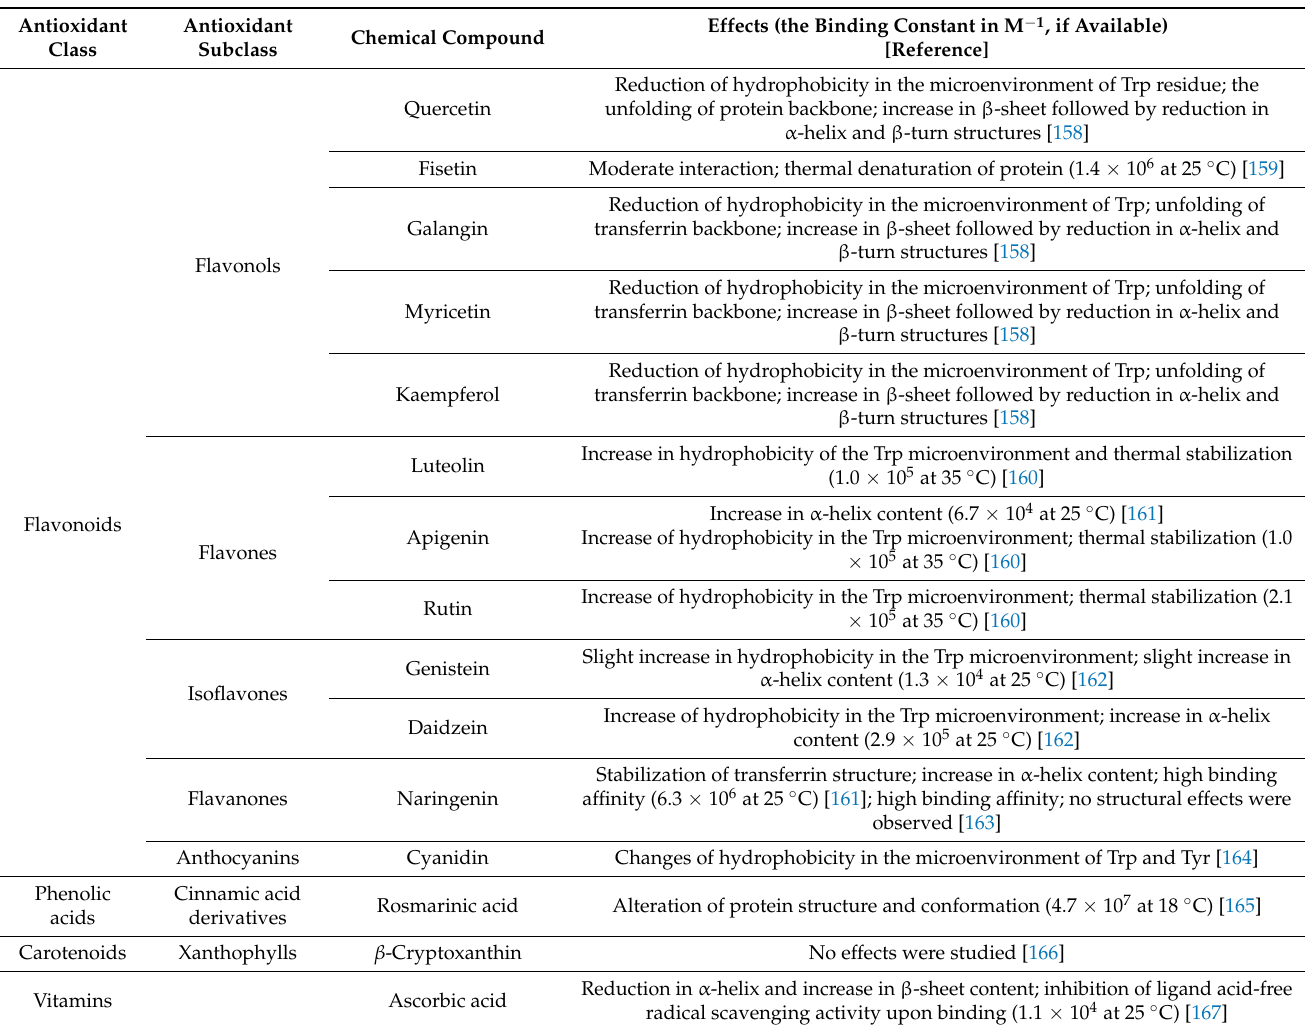
Table 2. Known interactions between food antioxidants and human transferrin.